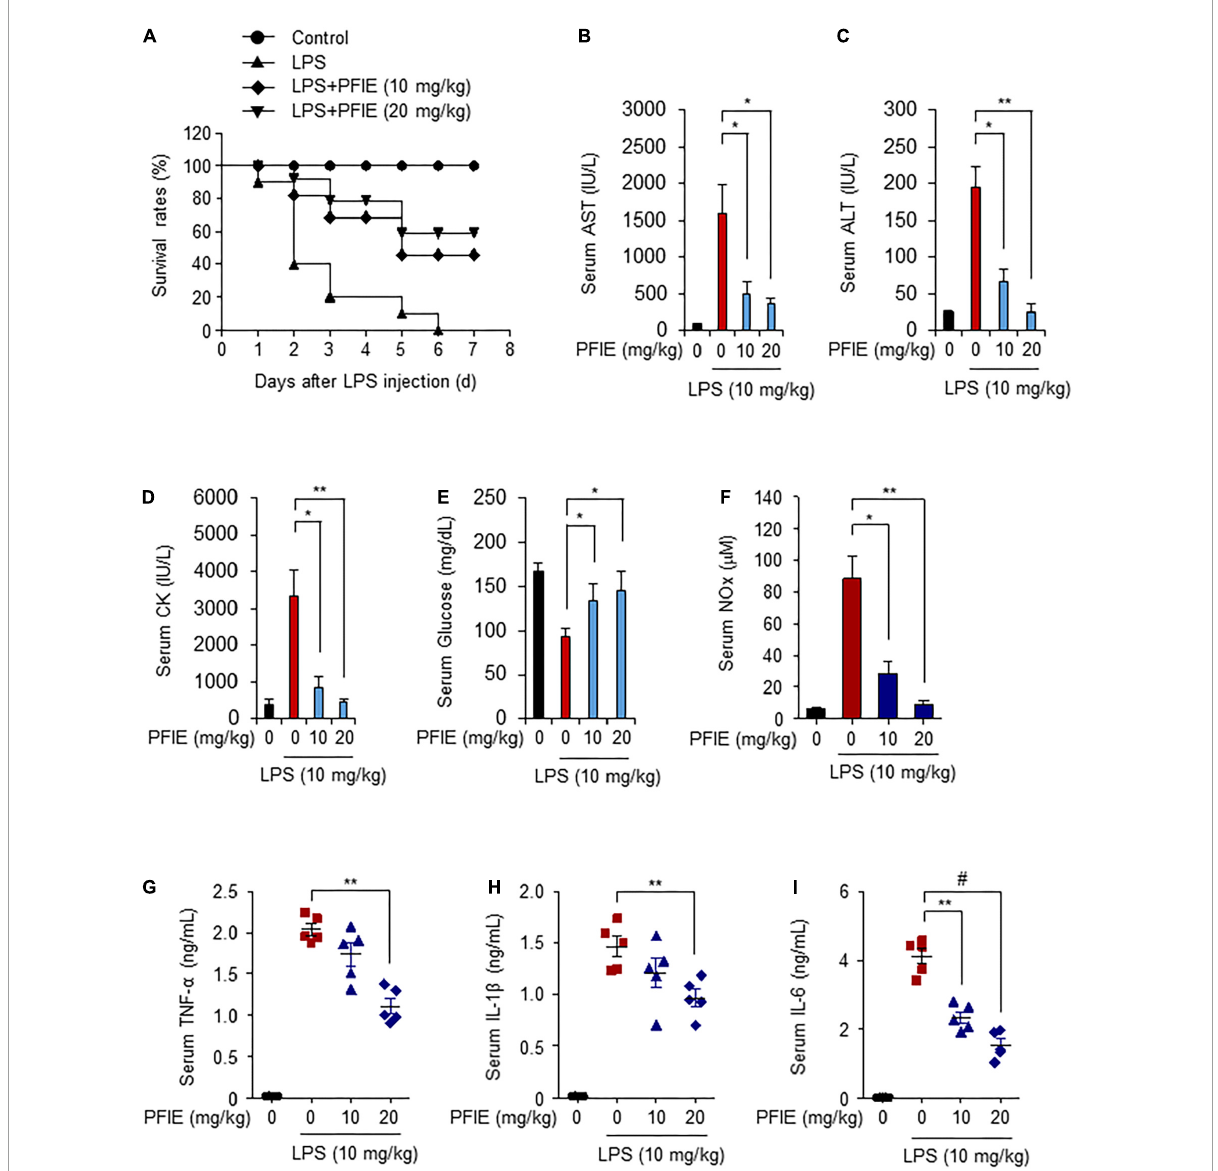
FIGURE4 PFIE prevents septic shock and attenuates proinflammatory responses in an LPS-induced endotoxemia mouse model. (A) Mortality was monitored for 7 days after LPS injection in the groups ( n = 10): PBS (circle); LPS (triangle); LPS + 10 mg/kg of PFIE (inverted triangle); and LPS + 20 mg/kg of PFIE (diamond). (B–I) Mouse serum samples ( n = 5) were collected 12 h after LPS injection. Serum levels of AST (B) , ALT (C) , and CK (D) measured using an automatic chemical analyzer. (F) Serum levels of nitric oxide (NO) metabolites measured using Griess